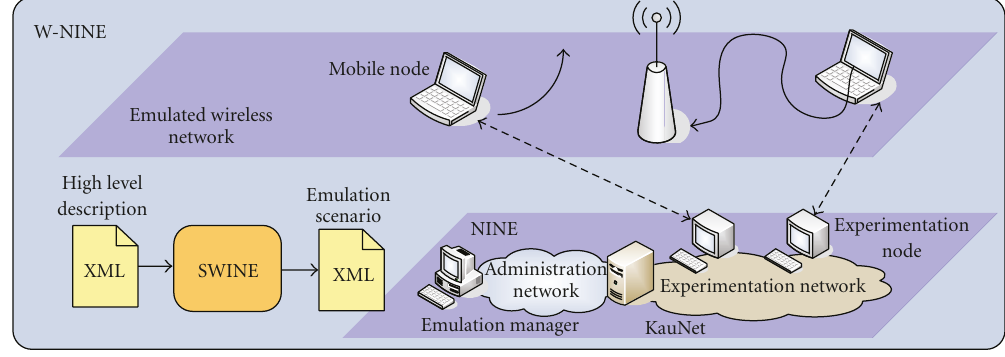
Figure 2: W-NINE